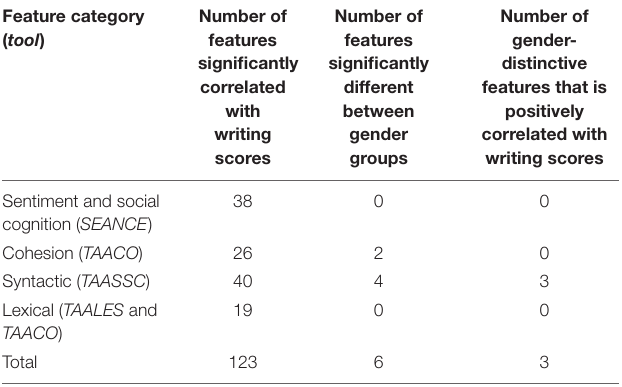
TABLE 5 | Summary of linguistic features studied for the gender groups. Feature category ( tool